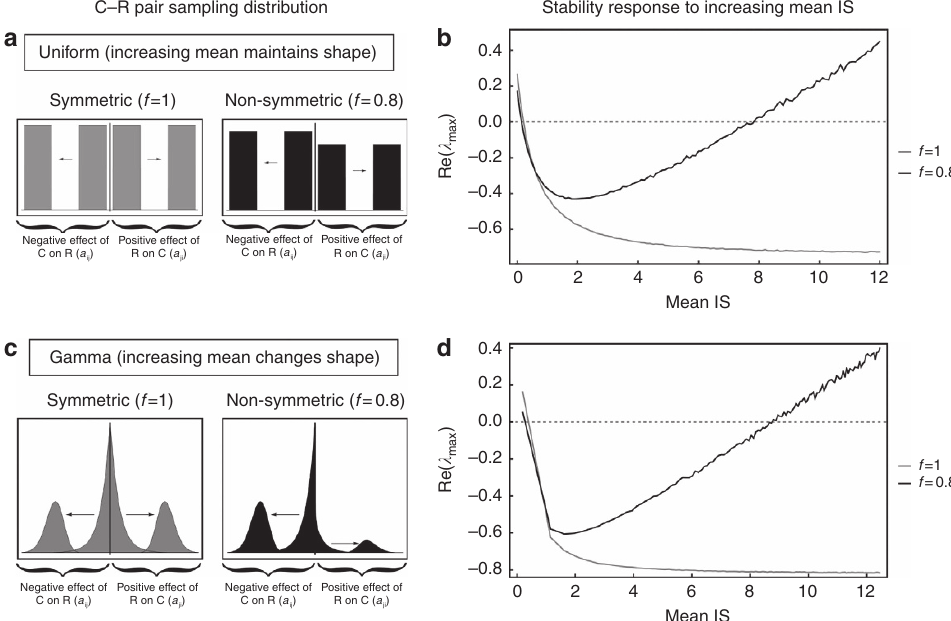
Figure 2 | Consistent stability pattern for large random trophic food webs. The role of increasing mean interaction strength (IS) and food web stability exhibits a universal checkmark stability signature ( b , d ) as long as the scaling of the consumer–resource (C–R) interaction pairs ( f ) is not exactly 1 ( a , c ). This signature does not depend on the shape of the C–R pair interaction distribution changing with mean interaction strength. We show two examples: fixed higher moments (Uniform, a ), changing higher moments (Gamma, b ) both have qualitatively identical patterns. For each model the diversity is set as S ¼ 250, connectance is set as C ¼ 0.25, with off-diagonal community matrix elements drawn from a uniform distribution Uniform ( r , r þ 1) with r ranging p within [0, 10] in steps of 0.1, and a gamma distribution G ð r ; 0 : 2 = ffiffi r Þ with r ranging within [1, 2,480] in steps of 20.0. In both models ( a , b ), for each value of r we created 100 random network topologies (location of non-zero matrix elements) and then 100 random community matrices and took the mean real part of the dominant eigenvalue as a measure of the stability and plotted this versus the mean of the C–R pair sampling